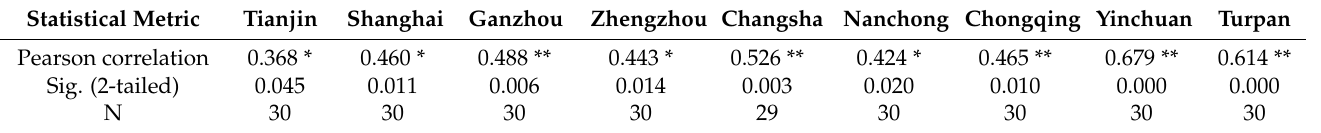
Table 3. Time series analysis of high-temperature days from 1986 to